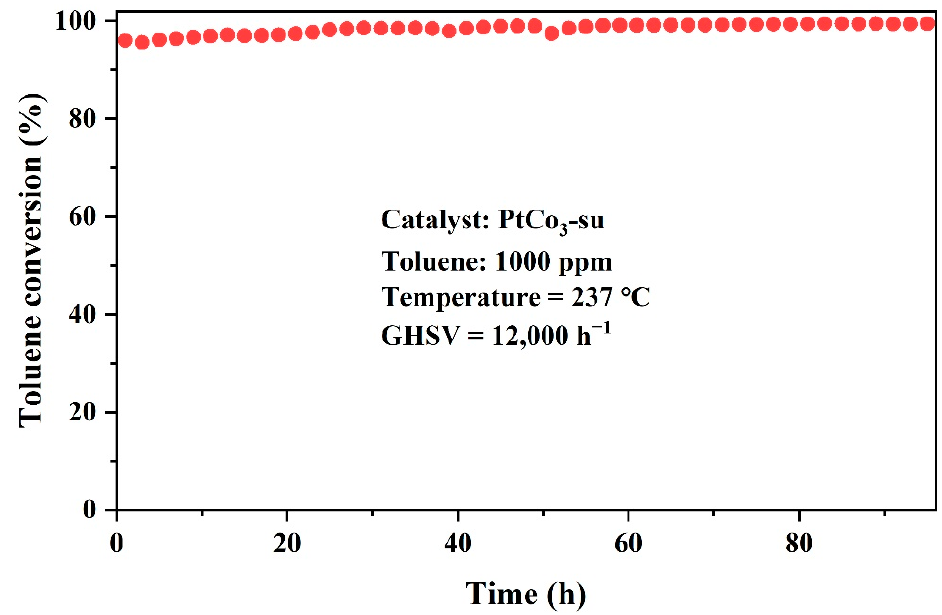
Figure 3. Reaction stability with time for toluene oxidation over PtCo 3 -su catalyst.